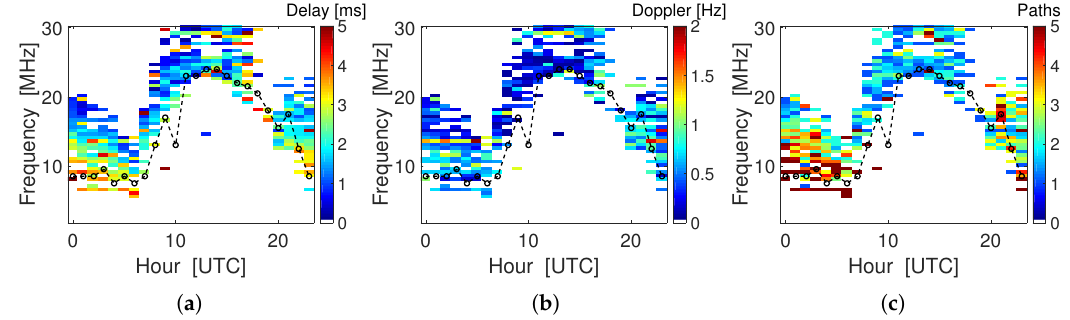
Figure 8. Comparison of the results for Campaign 2013–14 in terms of the delay and Doppler spread and number of paths against the narrowband frequency with largest availability (FLA). ( a ) Delay spread; ( b ) Doppler spread; ( c ) number of